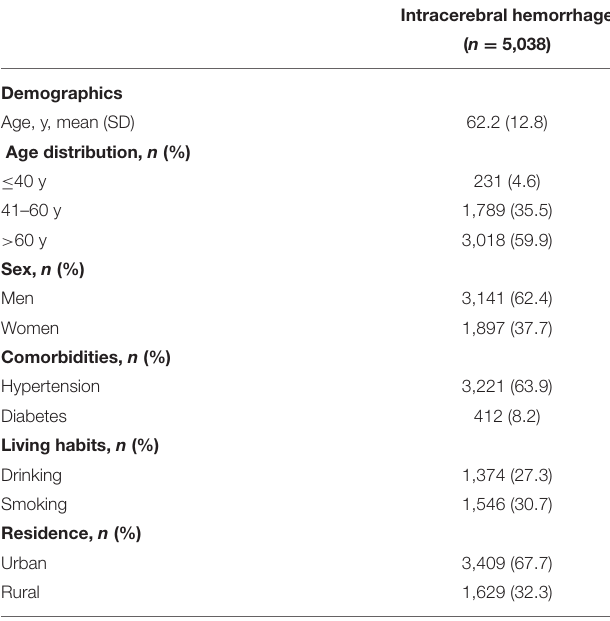
TABLE 1 | Characteristics of patients with first-onset intracerebral